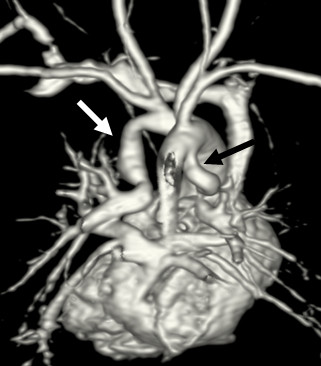
7-day-old girl with complex cardiac malformation including right isomerism, transposition of the great arteries and pulmonary atresia with non-confluent pulmonary arteries. 3D volume rendered CE-MRA image from posterior (with partial removal of the descending aorta) shows blood supply to the right lung via a PDA (black arrow) originating from the undersurface of the aortic arch, anastomosing with the native pulmonary artery at the hilum and with a distal stenosis > 50%. Blood supply to the left lung via a PDA (white arrow) originating from the innominate artery and anastomosing with the native pulmonary artery at the hilum.